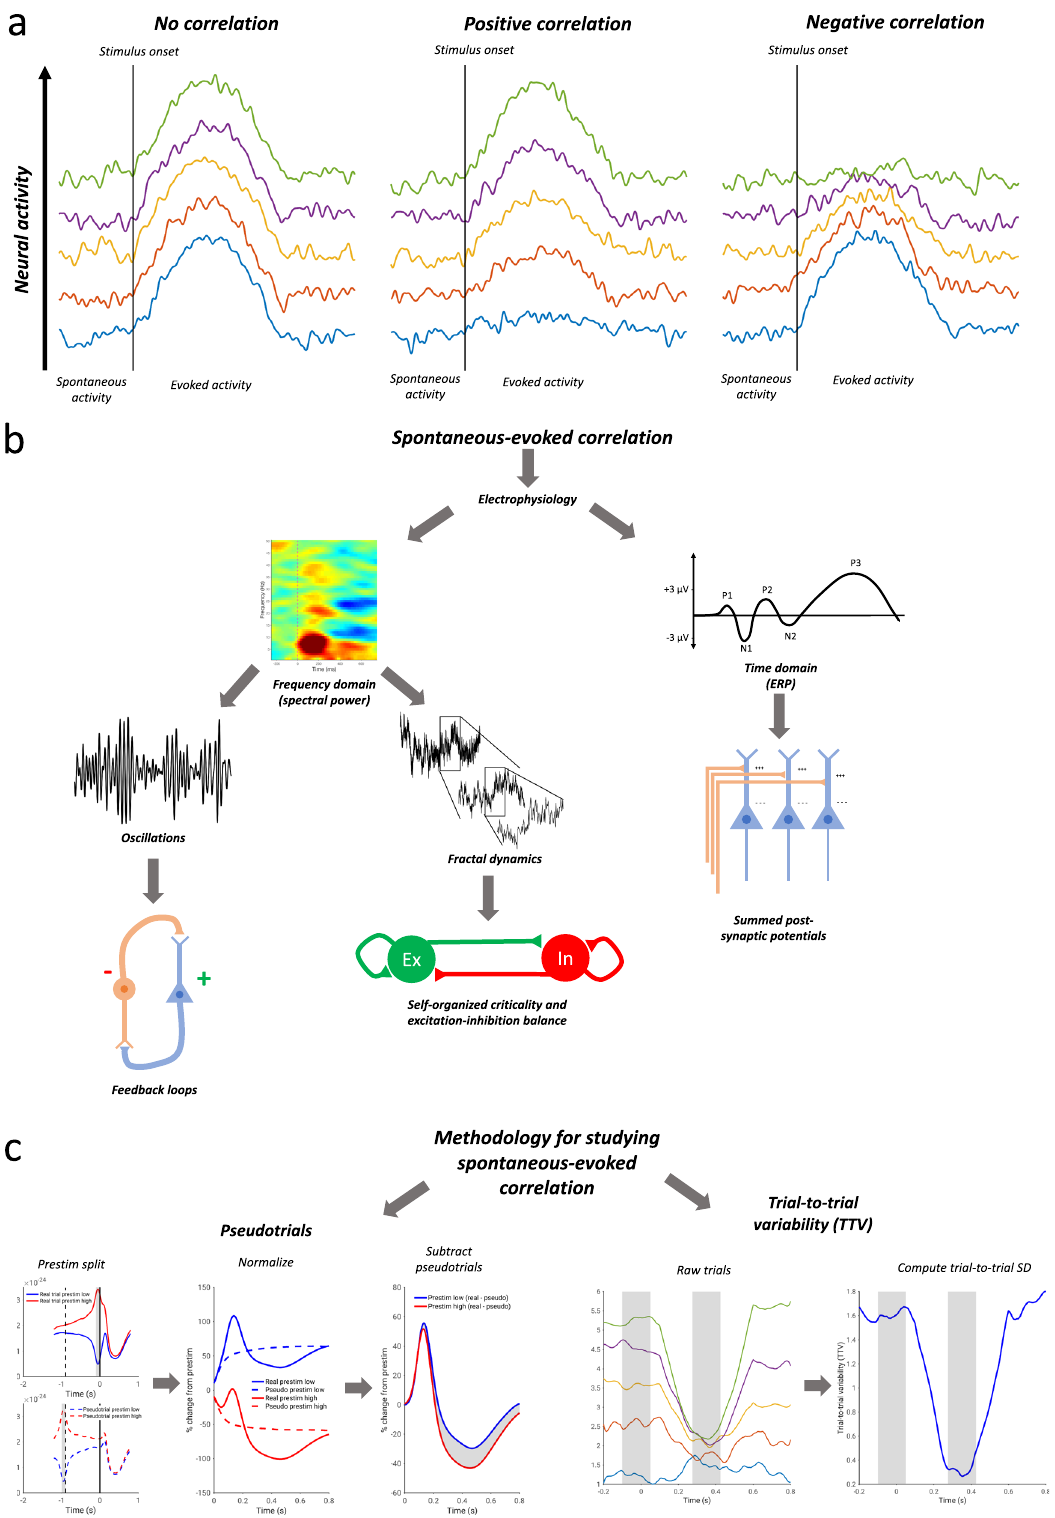
Fig. 1c, left). This corrects for ongoing spontaneous fl uctuations with the same initial conditions, and thereby corrects for regression to the mean of spontaneous activity 49 . If the trials with high prestimulus activity show a greater evoked increase (or smaller evoked decrease) than trials with low prestimulus activity, this is evidence for a positive correlation between spontaneous and evoked activity. If, by contrast, trials with high prestimulus